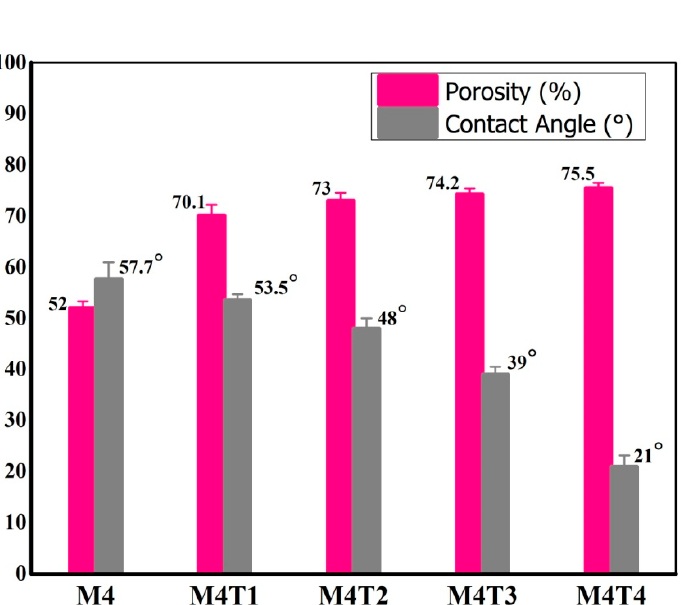
Figure 5. Pristine and nanocomposite membranes’ static water contact angle (average contact angles of samples are reported) and percent porosity. Table 2. TiO2/pore former effect on the performance of the pristine membrane and MMNMs.